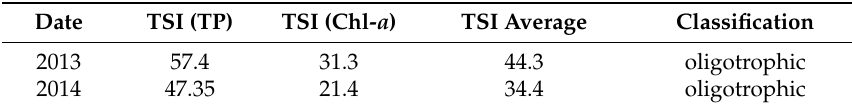
Table 5. EPA lake water quality classification system and estimated Carlson Trophic State Index (TSI) for Trichonis Lake.